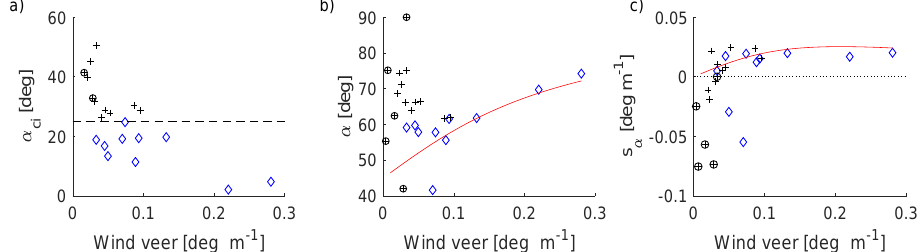
Figure 8. Confidence interval of the wake tilt angle α ci ( a ), mean wake tilt angle α ( b ) and slope s α of a linear fit of α over x ( c ) as a function of wind veer. The upper ordinate limit of the left panel ( a ) excludes three values. Blue diamonds indicate data points with a 95% confidence interval of α smaller than 25 ◦ and black pluses data points with a confidence interval larger than 25 ◦ (see black-dashed line in ( a )). The red lines in ( b , c ) show the corresponding prediction of the wake model (Equation (11)). Encircled data points indicate where the 2D-Gaussian fit rotated by 90 ◦ (see Appendix